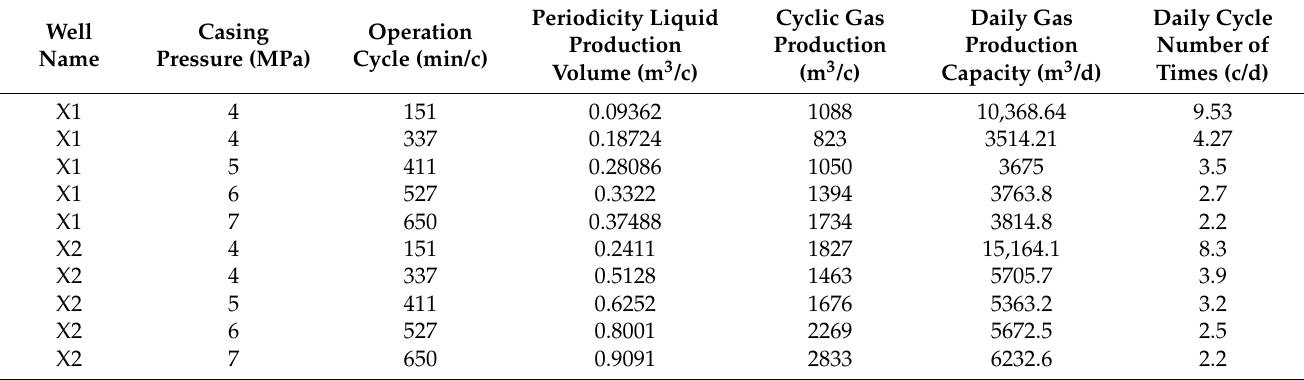
Table 2. Gas production in different work system designs.